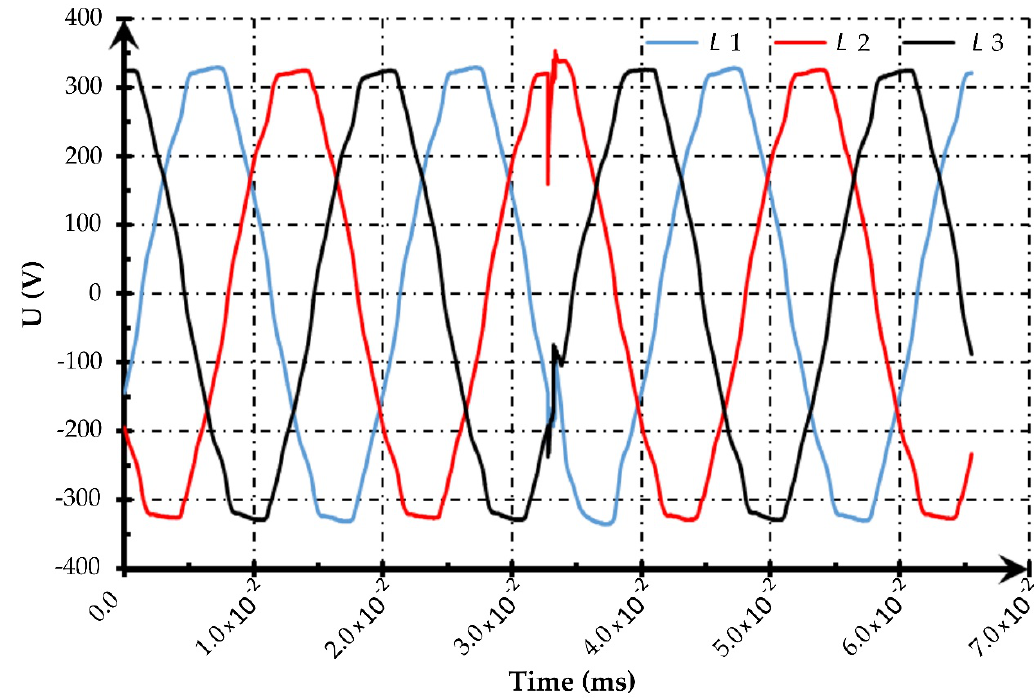
Figure 7. Rapid changes in voltage example 2.